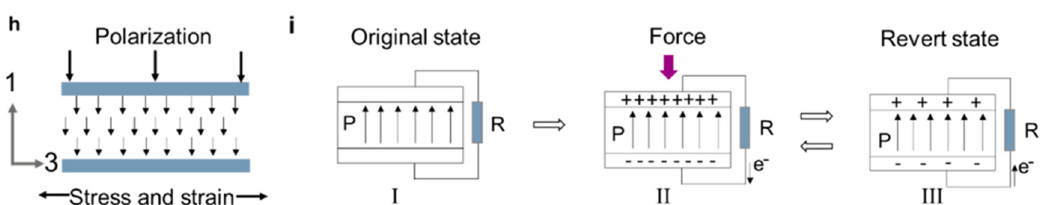
Figure 25. Representation of a self-powered photodynamic therapy system proposed by Liu et al. [113]. ( a ) This system includes a ts-PENG, a PMU, an m-LED, and a photosensitizer. ( b ) Materials of the different layers of the ts-PENG considering the packaging and substrate. ( c ) Representation of the s-PDT used in the apoptotic process of subcutaneous tumor tissue. ( d ) SEM image of the cross section of the st-PENG. ( e ) Image of the initial state of the ts-PENG. ( f ) Image of the bending state of the ts-PENG. ( g ). Weight of the ts-PENG. ( h ) Schematic view of the d 31 operating mode of the PVDF film. ( i ) Operating principle of the PVDF film. Reprinted with permission from [113]. Copyright ©2020, American Chemical Society.